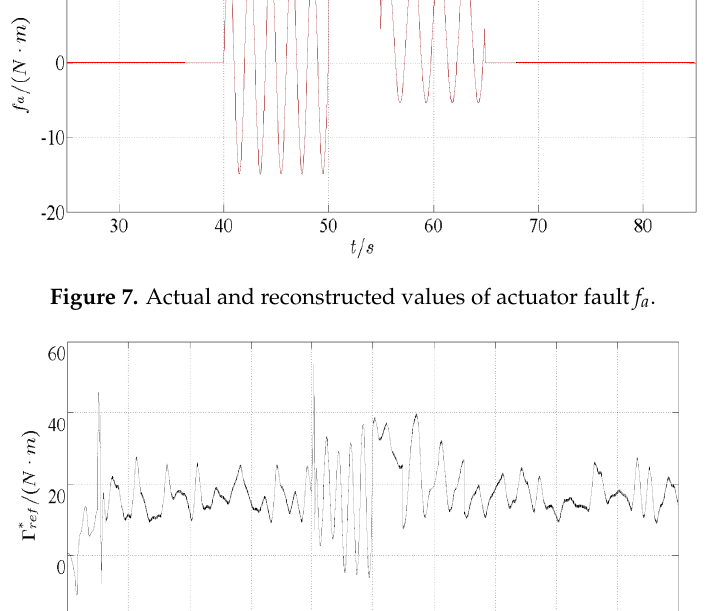
Figure 8. Reference value of electromagnetic torque Γ ∗